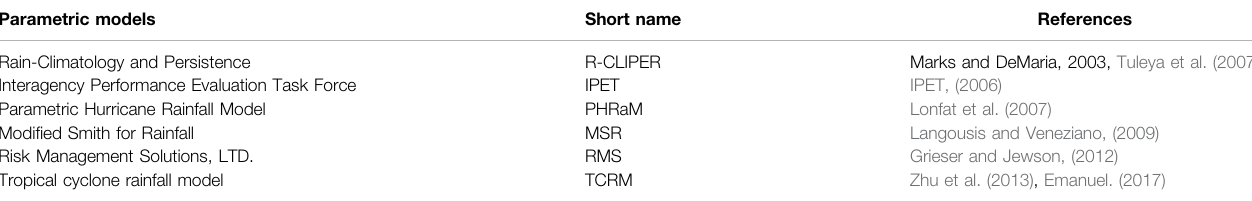
TABLE 2 | Parametric models for tropical cyclone